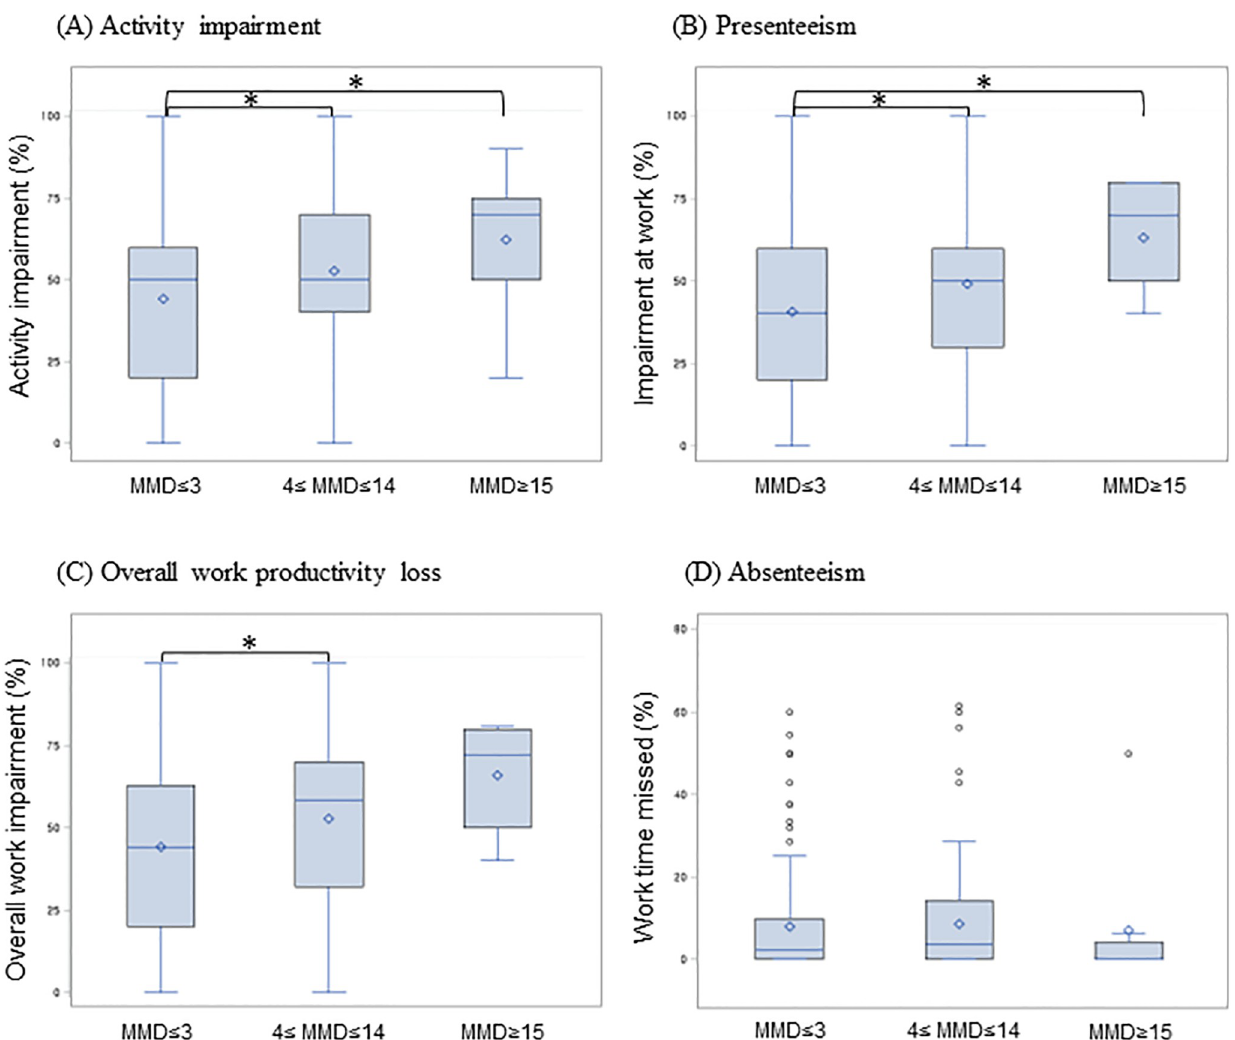
Fig 2. The impact of monthly migraine days on Work Productivity and Activity Impairment during previous 1-week. (A) Activity impairment (N = 362) (B) Presenteeism (N = 265) (C) Overall work productivity loss (N = 265) (D) Absenteeism (N = 265) � p <